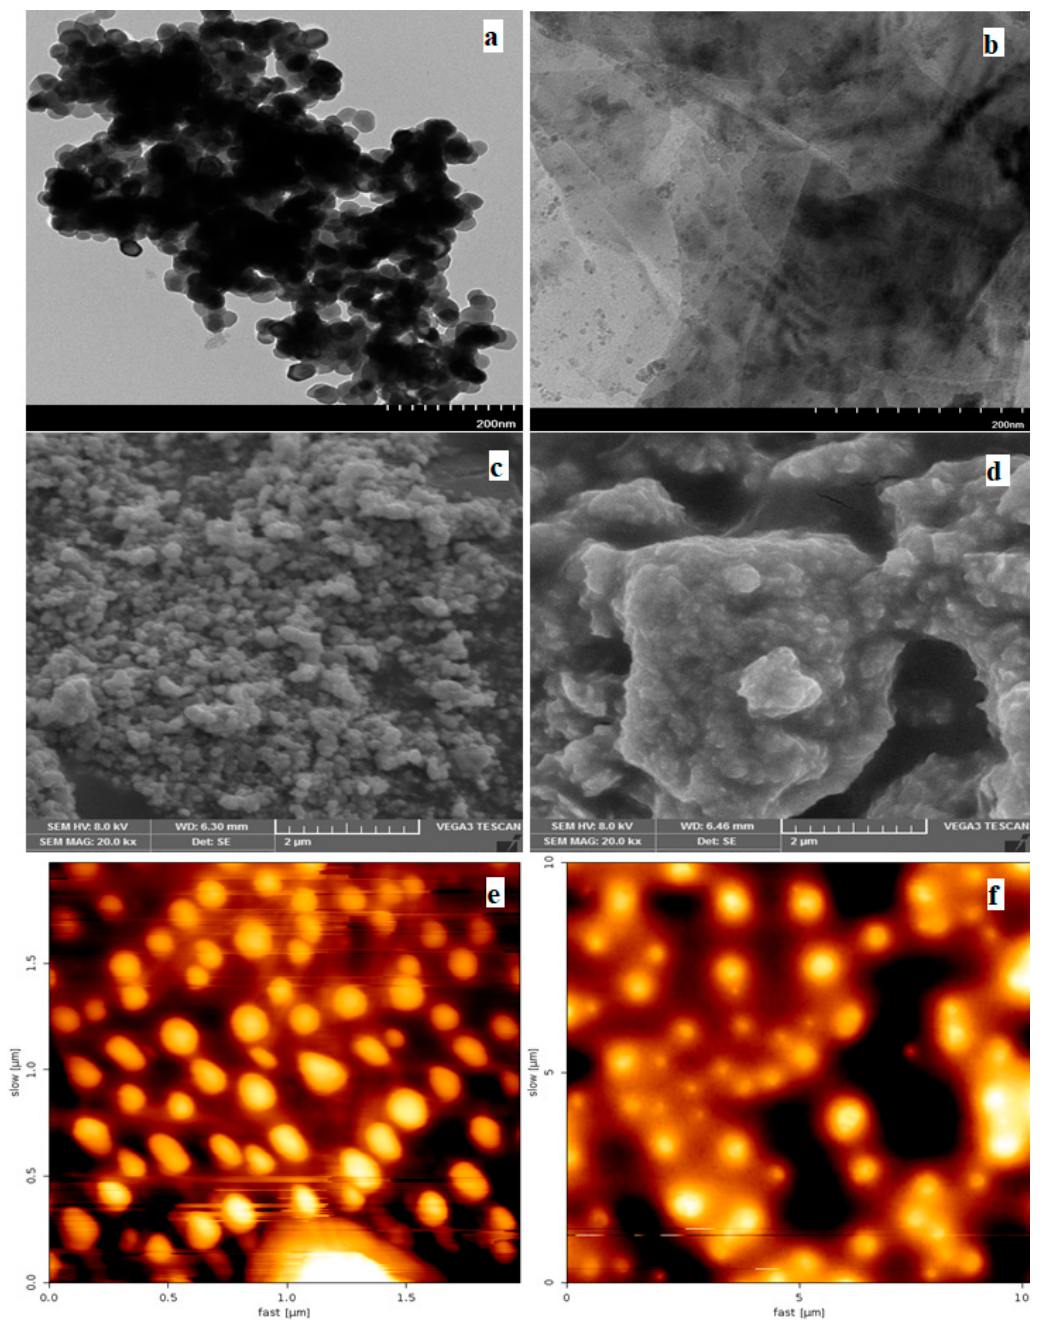
Figure 1. TEM, SEM, and AFM images of Cu 2 O-Co 3 O 4 ( a , c , e ) and Cu 2 O-Co 3 O 4 /CN composites ( b , d , f ). FTIR analysis was carried out in transmittance mode to confirm the formation of composites (Figure 2). The transmittance peaks at 645 cm − 1 and 540 cm − 1 belongs to cobalt oxide and copper oxide, and it is present in both materials, while the peak at 1100 cm − 1 is due to the presence of -O-C-O- vibrations [41]. The peak presence at 3300 cm − 1 is